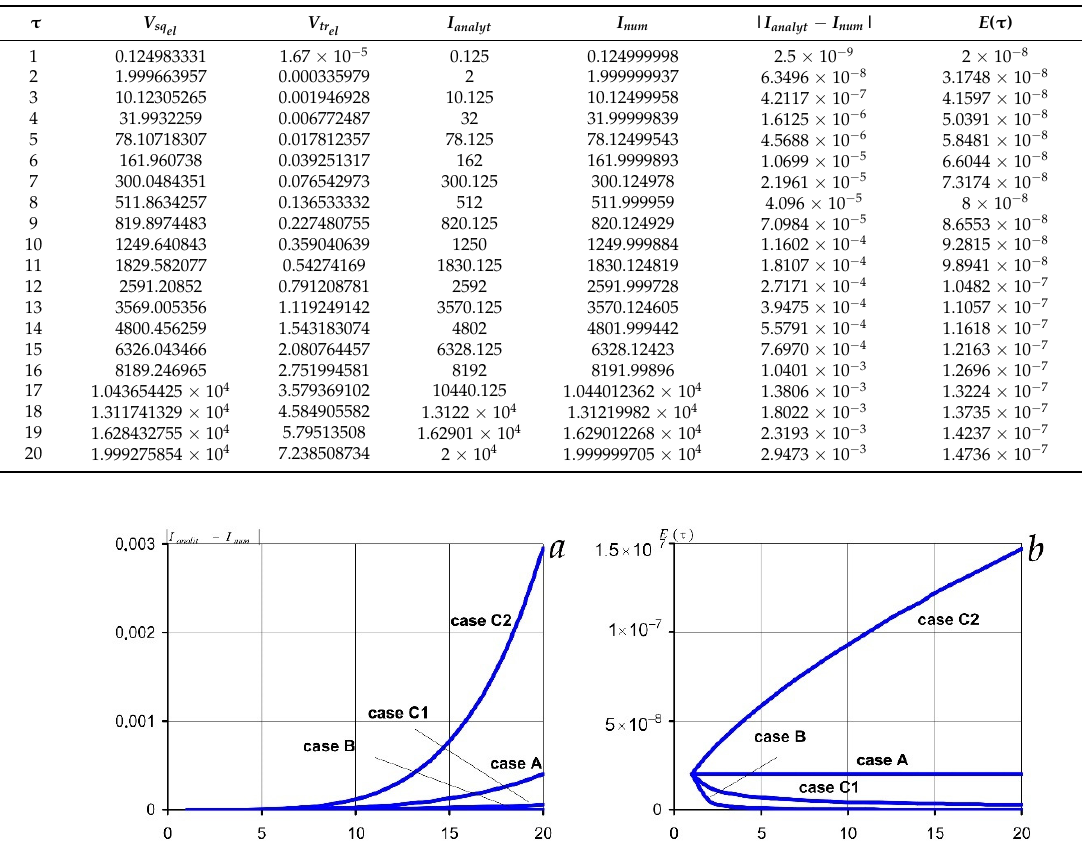
Table 4. Calculation of integral